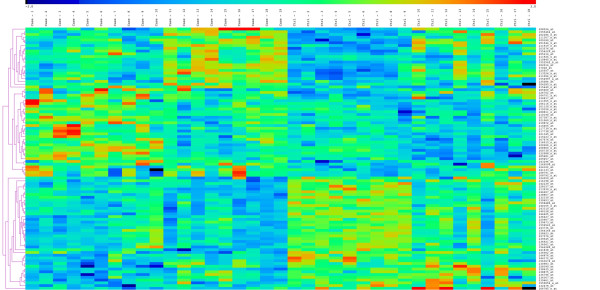
Hierarchical clustering of differentially regulated genes in the setting of PAD. Clustering was performed using hierarchical clustering algorithm with Euclidean distance and average linkage clustering method.